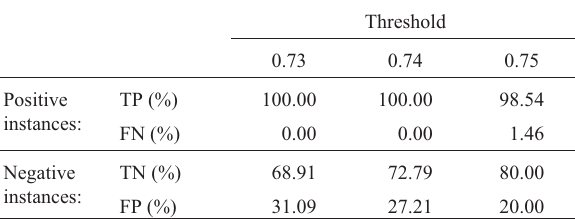
Table 8 - Performance evaluation for model 3.